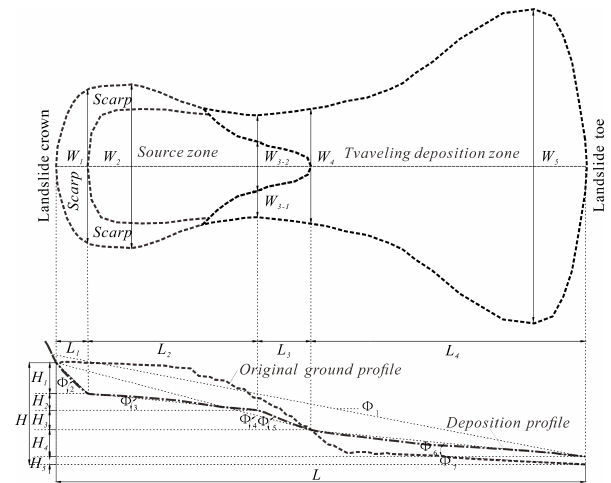
Figure 11. Simplified illustration of the flowslide geometry. L